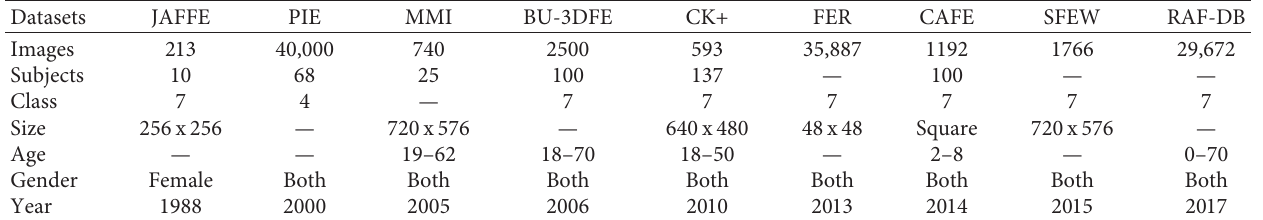
Table 1: Overview of the existing facial expression